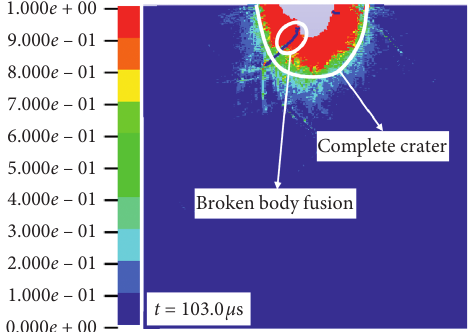
Figure 6: Fusion of broken bodies on the upper and lower sides of steel